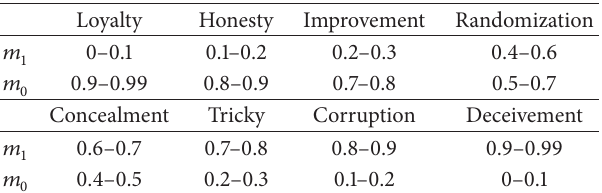
Table 1: Typical group